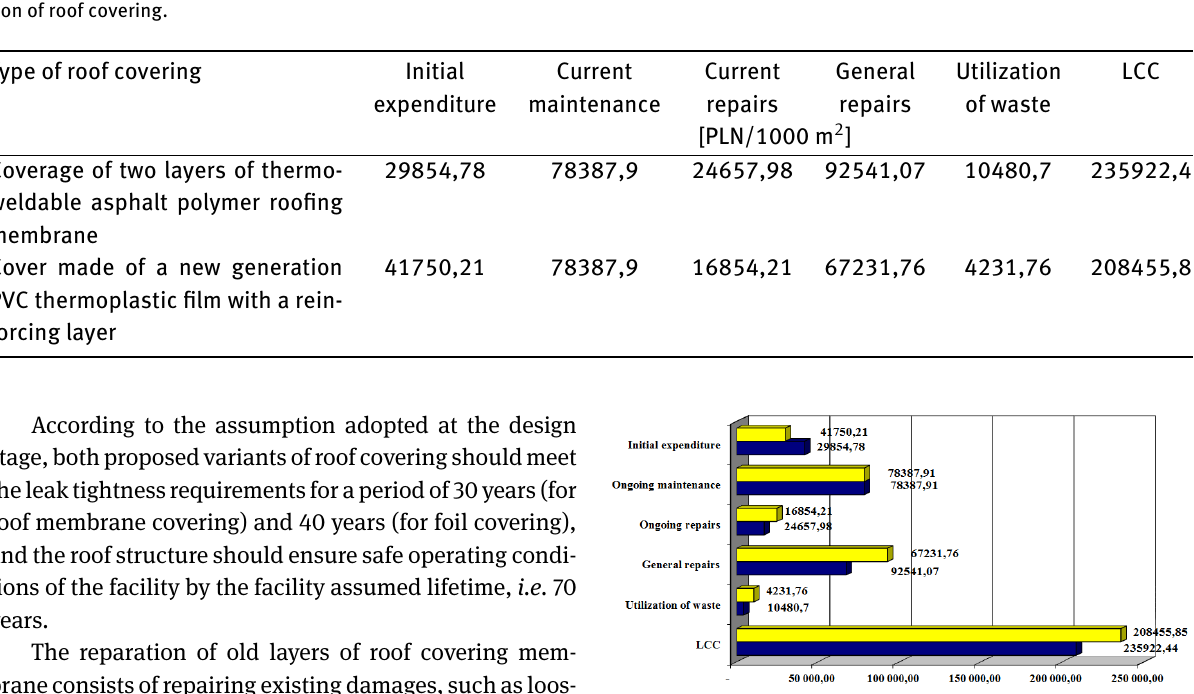
Table 1: Components of life cycle costs for two alternative technologies of production, maintenance in the period of 70 years and elimina- tion of roof covering.